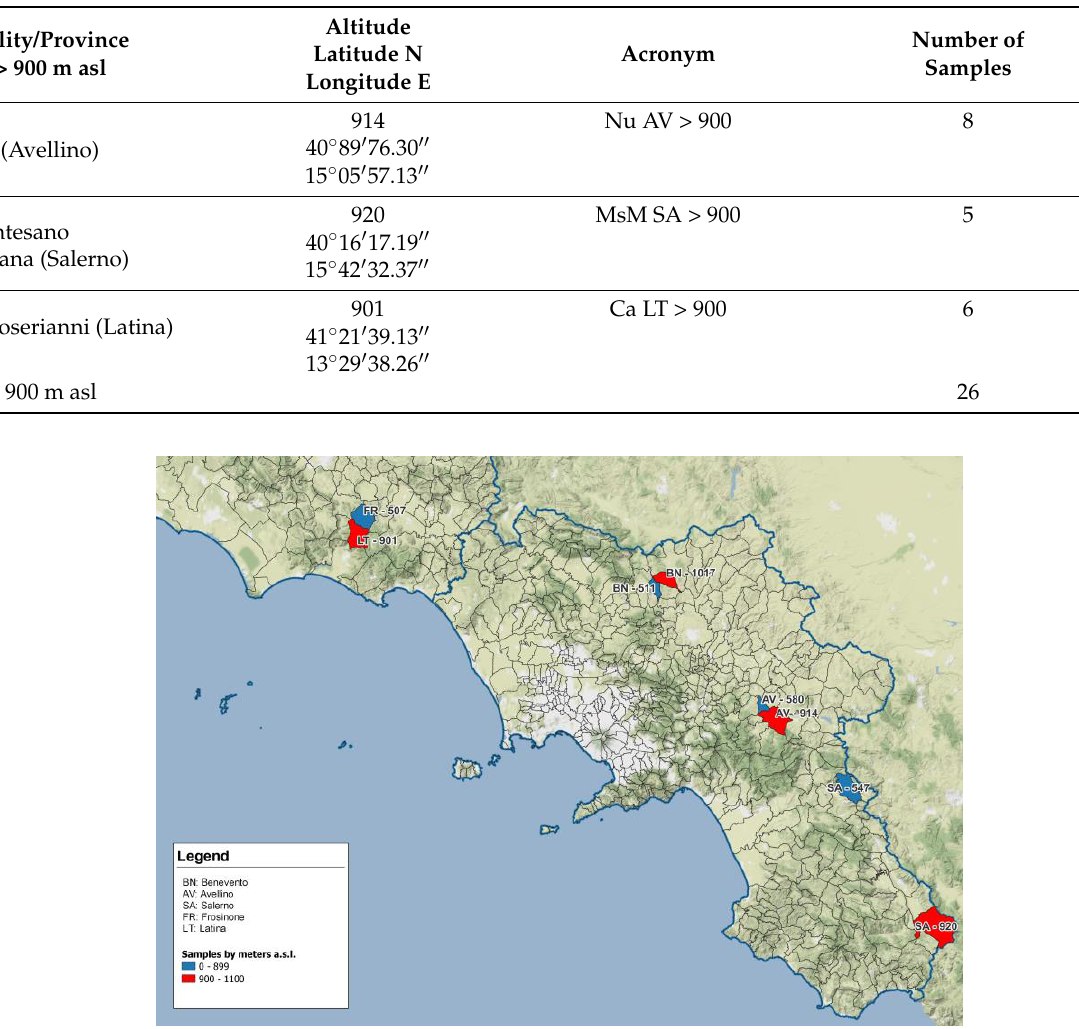
Figure 1. Geographical map presenting localization of sampling sites in Campania and Latium region: sites located >900 m asl are in red, sites located <900 m asl are in blue. Blue line indicates the geographical border between regions.